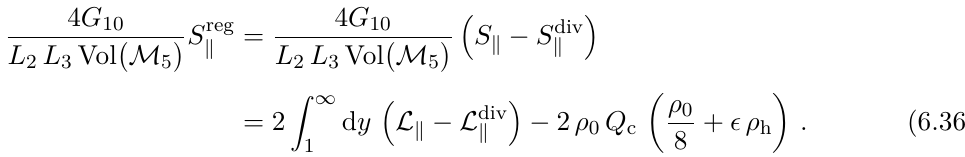
figure 4. The (cid:15) correction increases the value of the width, while it decreases slightly the value of the entanglement entropy for small ˜ l